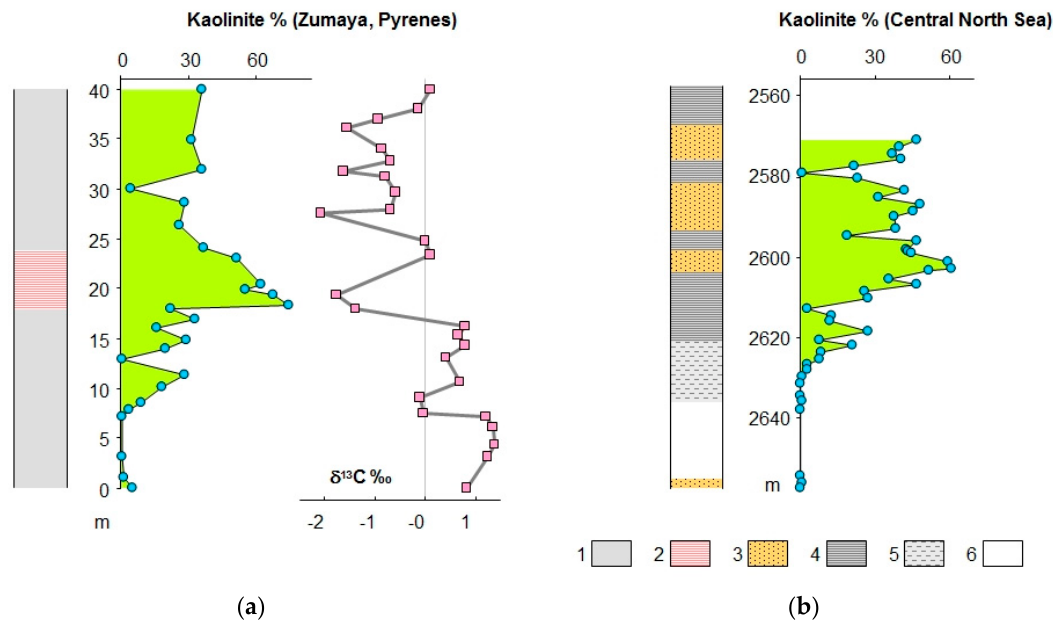
Figure 1. Examples of the clay mineral expression at the Paleocene–Eocene Thermal Maximum (PETM) showing strong increase of the kaolinite content, from almost zero up to > 60% (grain size not specified); simplified lithology: 1 = grey mudstone / marl with turbidites; 2 = red–brown unit; 3 = sandstone; 4 = laminated dark–gray mudstone; 5 = poorly laminated grey mudstone; 6 = unbedded grey–green and red mudstones; redrawn from [61]. ( a ) Zumaya, Pyrenes; ( b ) Central North Sea